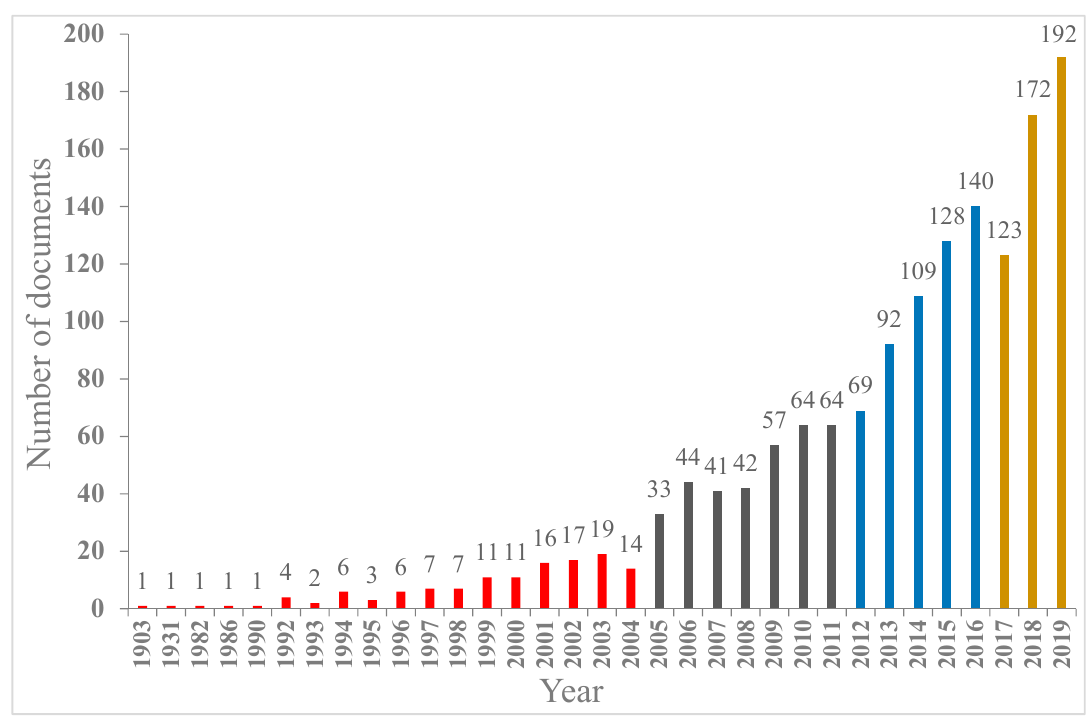
Figure 4. Farmland abandonment research documents published from 1903 to 2019.